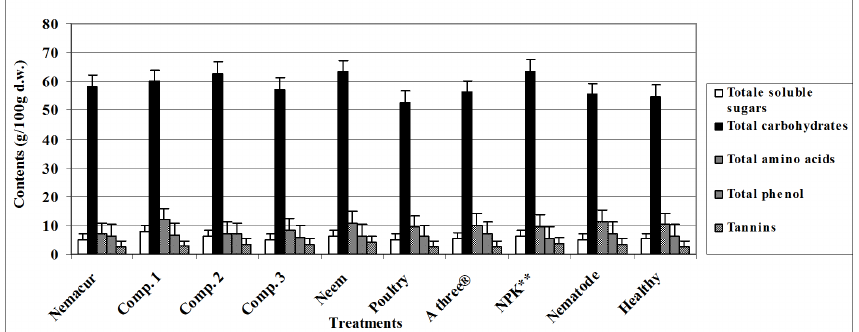
Fig. 1. Biochemical contents (g/100 g d.w.) alterations in tomato roots as influenced by M. incognita infection and the application of organic and inorganic fertilizers.